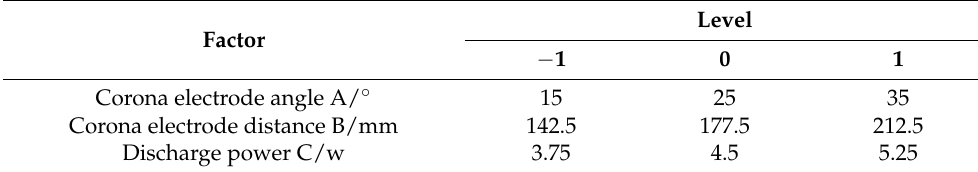
Table 1. Factor and level coding of the response surface analysis.